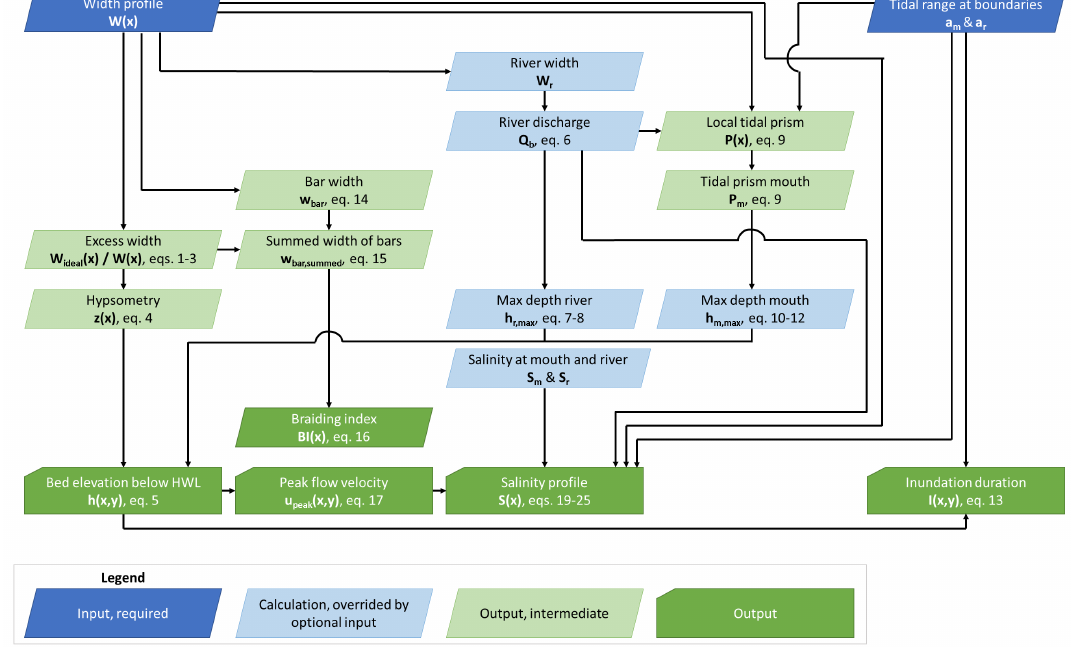
Figure 3. Flowchart of the calculation steps in the